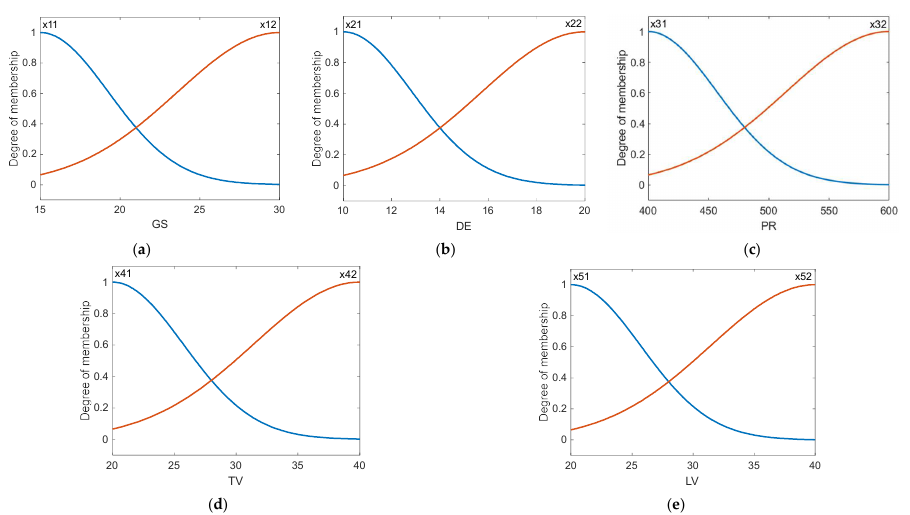
Figure 4. Membership functions for fuzzification of the inputs for: ( a ) GS; ( b ) DE; ( c ) PR; ( d ) TV; ( e ) LV.